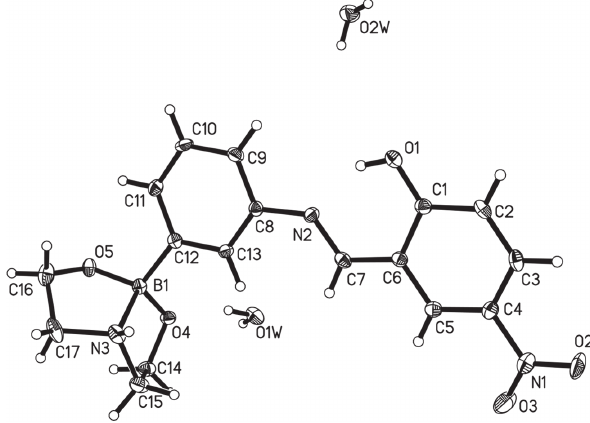
Table 1: Data collection and handling.